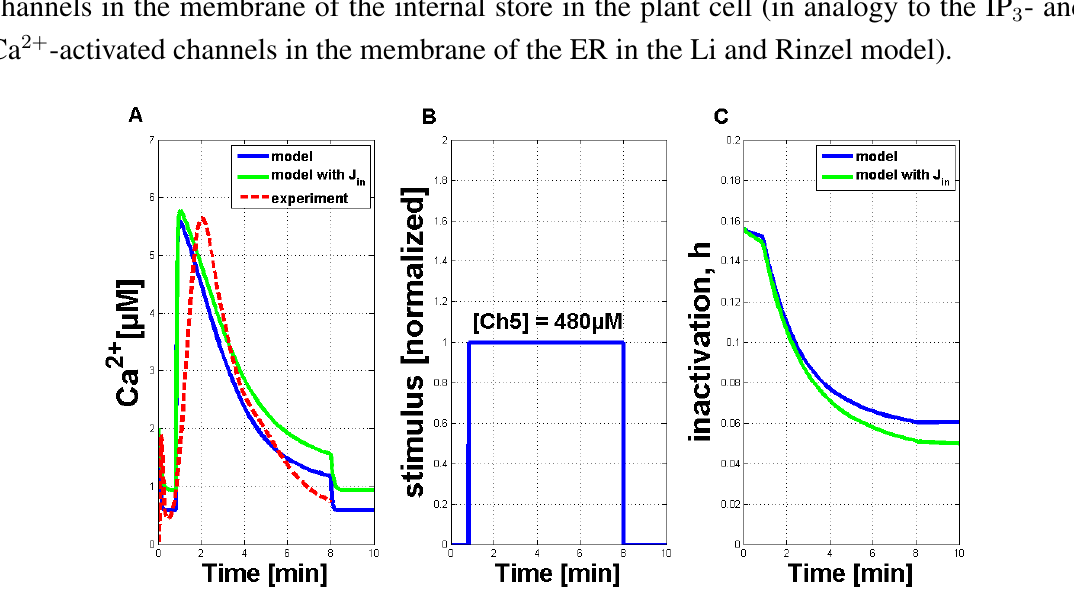
Figure 3. Qualitative comparison of measured Ca 2+ transients and simulations of Ca 2+ transients with the adapted Li and Rinzel model. ( A ) Comparison of measured cytosolic Ca 2+ concentration in tobacco plant cells treated with 480 µM of Ch5 (dashed red line) and simulation with modified values for adapted parameters (solid blue curve), as listed in Table 1 (without the J flux). A second simulation (solid green line) is shown under the same in circumstances, additionally containing a constant influx, J , through the plasma membrane. in ( B ) IP stimulus used for the activation of the system. The value of one of the normalized x input corresponds to a Ch5 concentration of 480 µM. ( C ) The inactivation process of the channels in the membrane of the internal store in the plant cell (in analogy to the IP - and 3